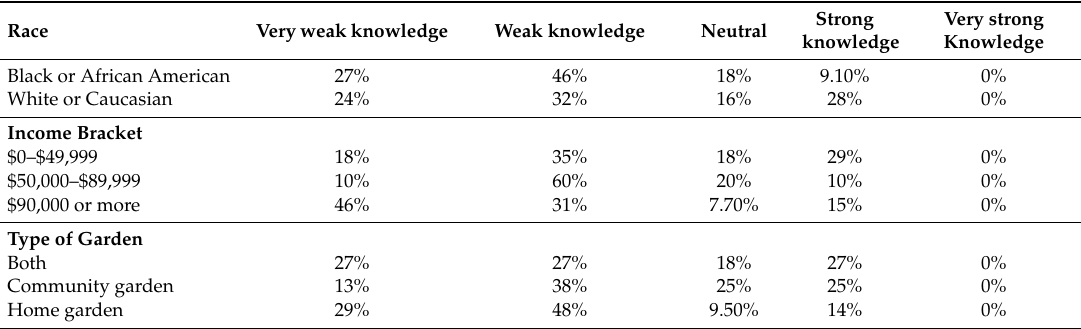
Table A11. Participants’ knowledge of soil remediation